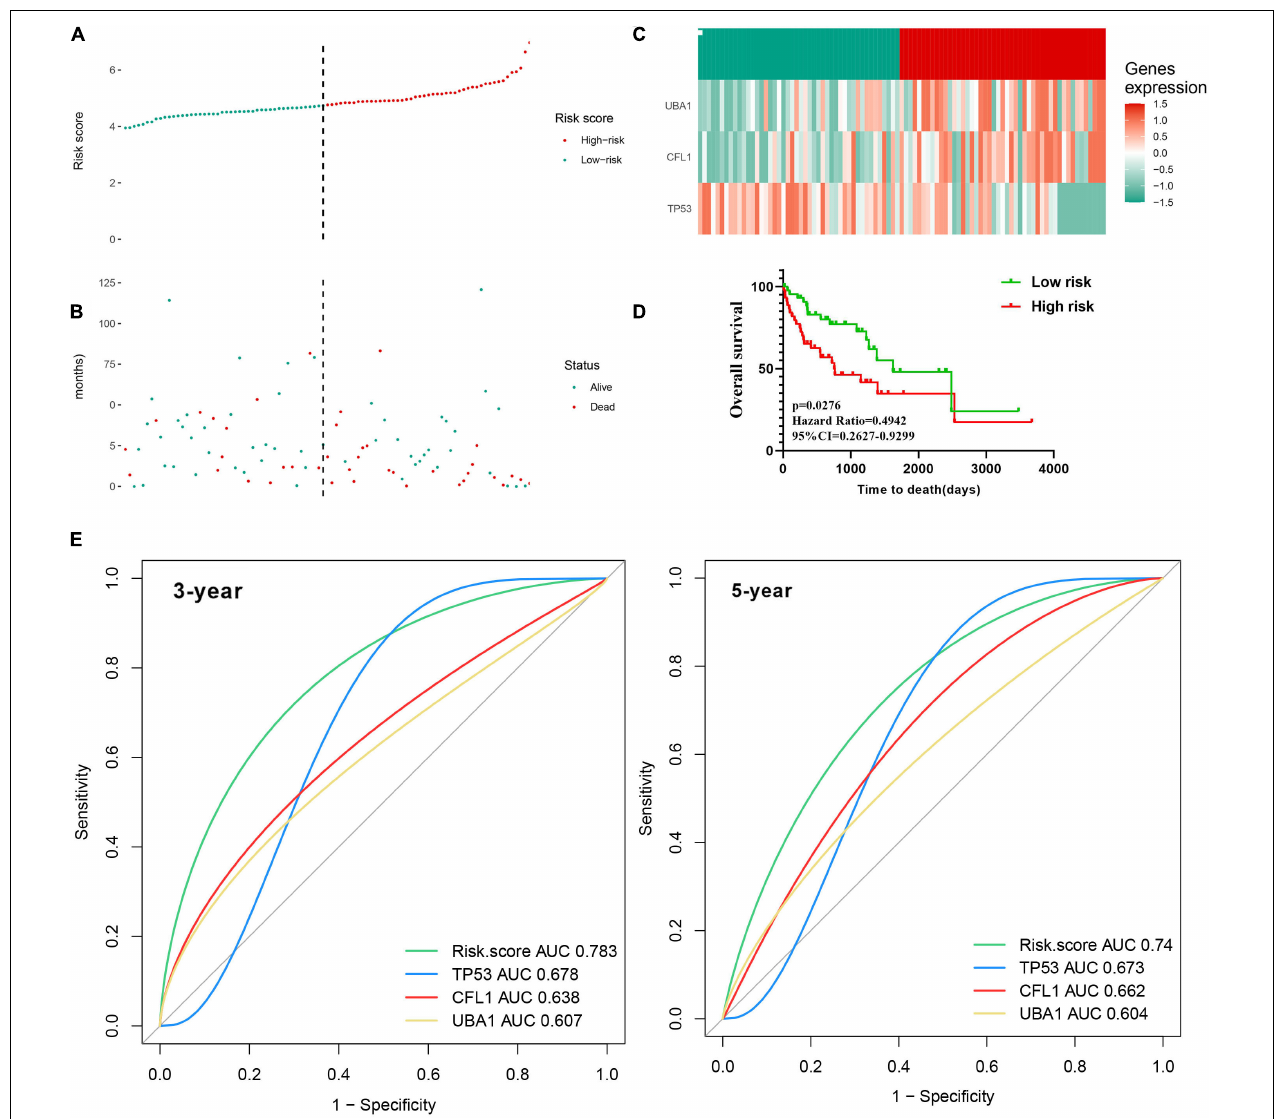
FIGURE 7 | Construction of the three-gene signature in the training cohort to predict OS for HBV carriers with HCC development. The patients were classified into low-risk and high-risk groups by the dotted line, representing the median risk score. Assignment of (A) risk score, (B) survival status of the patients, and (C) the expression profiles of the three risk genes in the training cohort, separately. (D) Kaplan–Meier curves of OS according to the risk score in the training cohort. (E) Time-dependent ROC curves of the risk score were adopted to estimate the predictability of OS at 3 years and 5 years in the training cohort. OS, overall survival; ROC, receiver operating